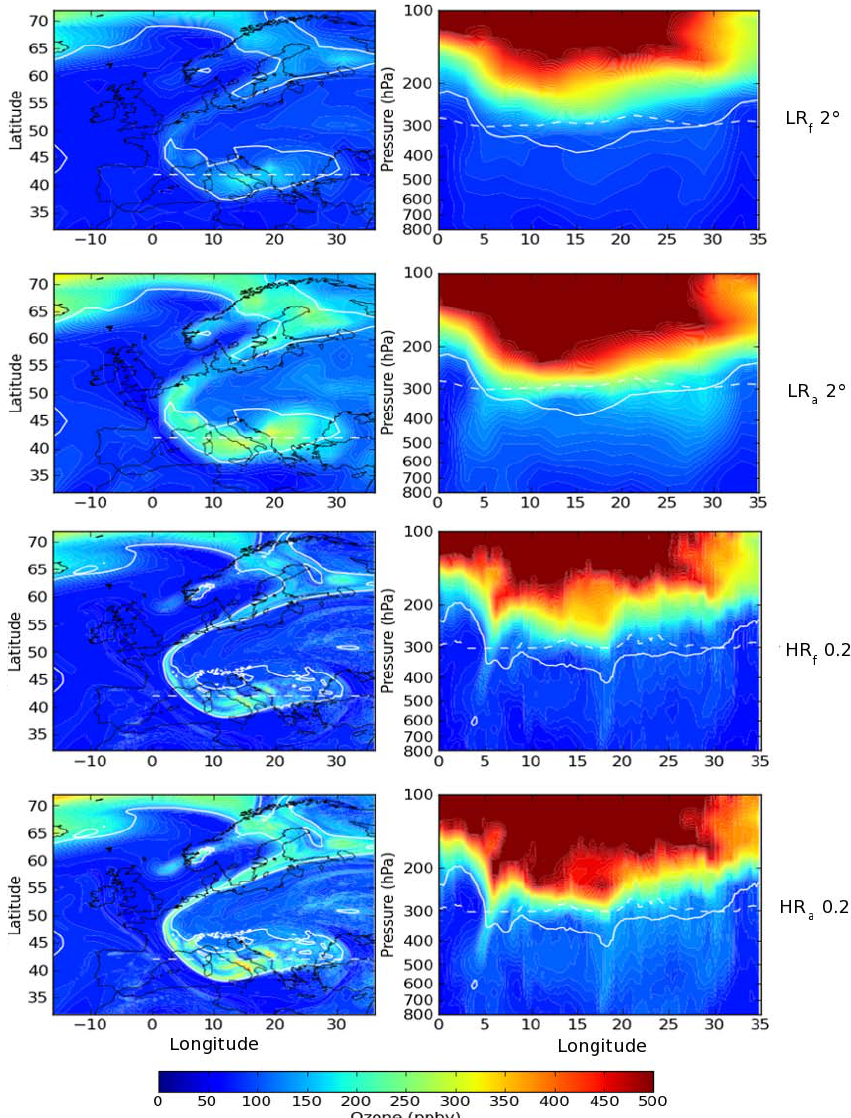
Fig. 4. Ozone fields for 23 June 2009, 12:00UT, in ppbv (parts per billion by volume) for various experiments: LR f : Low Resolution (2 ◦ ) free run; LR a : Low Resolution (2 ◦ ) analyses; HR f : High Resolution (0.2 ◦ ) free run and HR a : High Resolution (0.2 ◦ ) analyses. Left hand side panels show longitude-latitude fields for a given model level; right hand side panels show longitude-pressure cross-sections. White dashed line associate vertical and horizontal distribution by showing the same location between left hand side and right hand side panels. The white solid lines identify the 2PVU